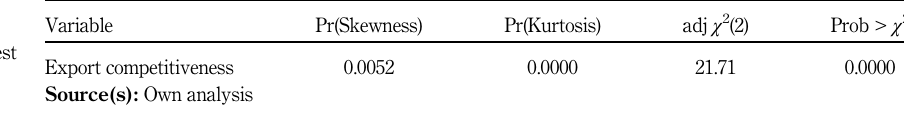
Figure 2. Showing the Q – Q plot